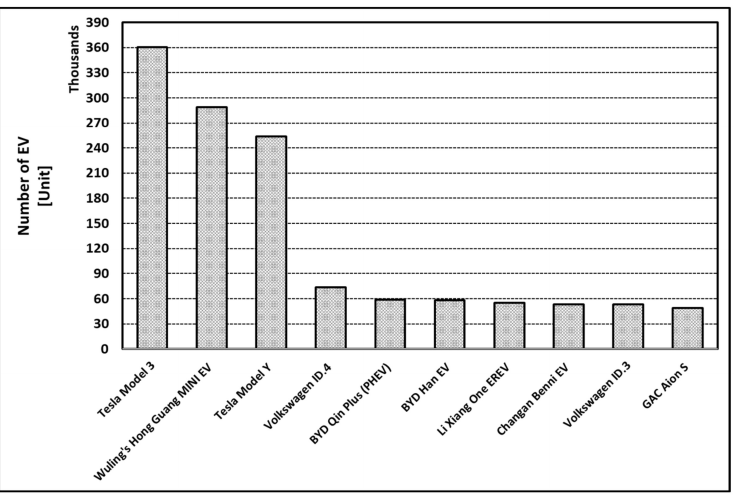
Figure 7. The numbers of best-selling EVs worldwide by model between January and September 2021.